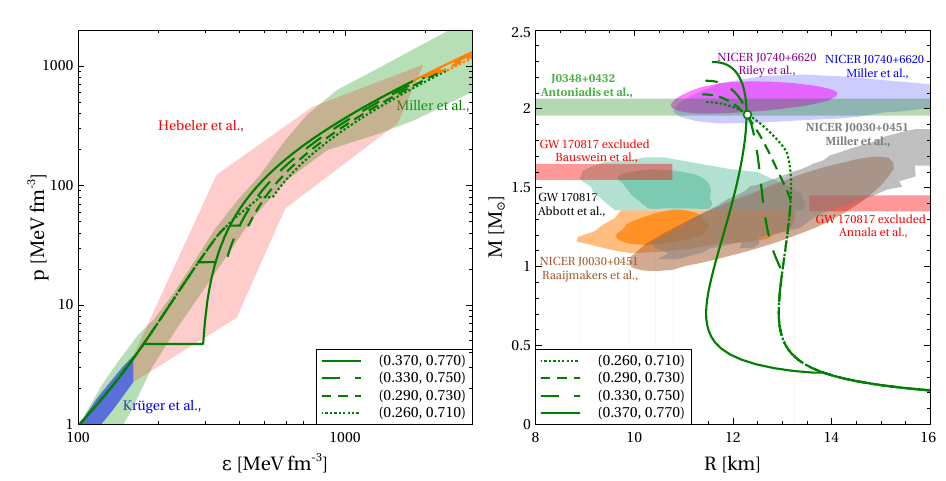
Figure 4. The same as in Fig. 2 but for the quark matter EoS obtained with density dependent couplings.